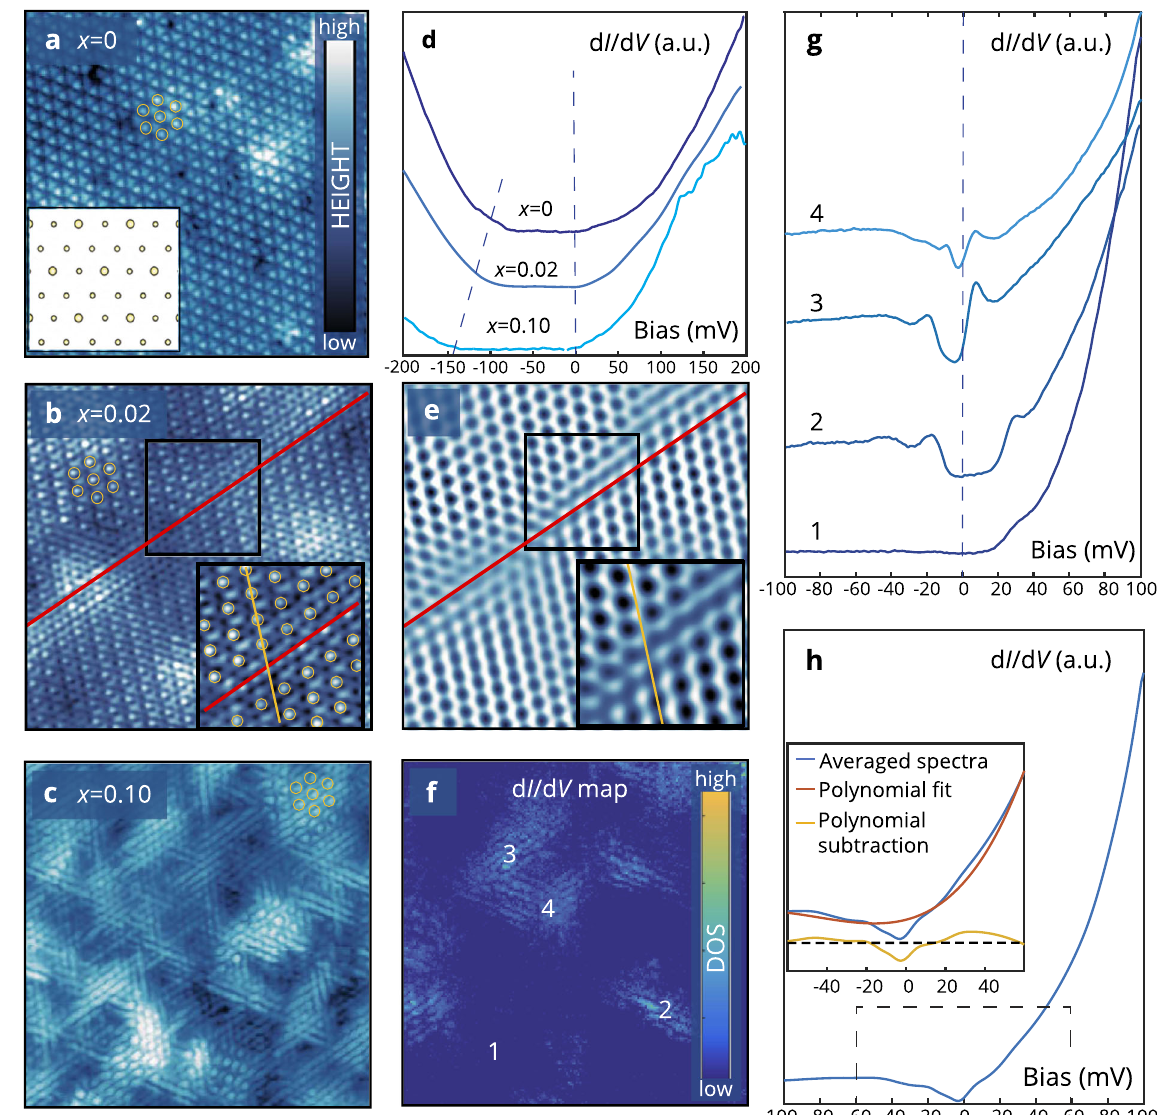
Fig. 4 STM topography and tunneling spectra on Pt x Ti 1 − x Se 2 . a 14 nm × 14 nm TiSe 2 topography image acquired at 4 K, I = 20 pA, and V = 100 mV. The orange circles enclose CDW maxima. The inset represents a sketch of the CDW order distribution in the top Se layer. The large (small) yellow dots indicate CDW maxima (minima). b 14 nm × 14 nm topography image of x = 0.02 Pt-doped TiSe 2 acquired at 4 K, I = 200 pA, and V = 50 mV. The red line indicates a CDW domain wall. The orange circles enclose CDW maxima. The inset is a magni fi ed view of the region within the black square. The orange line shows the π -shift between domains. On one side of the domain wall, the orange line intersects the atoms while on the other side, it passes between the atoms. c 14 nm × 14 nm topography image of x = 0.1 Pt doped TiSe 2 acquired at 4 K, I = 150 pA, and V = 100 mV. The orange circles enclose CDW maxima. d Most common spectra measured for x = 0, 0.02, 0.1 doping. e Selective inverse Fourier transform of CDW peaks calculated from b . The red line indicates the position of the CDW domain wall. The inset is a magni fi ed view of the area within the black box and the orange lines show the π -shift between domains. f d I /d V image recorded at V = − 20 mV on the same area shown in c . g Averaged spectra measured on areas 1, 2, 3, and 4 of f . h d I /d V spectra averaged over the entire area of f . The inset shows the difference between the averaged spectrum and the polynomial fi t. In the topographies data, bright colors and dark colors correspond to higher and lower heights respectively, while they correspond to higher and lower densities of states in d I /d V data,